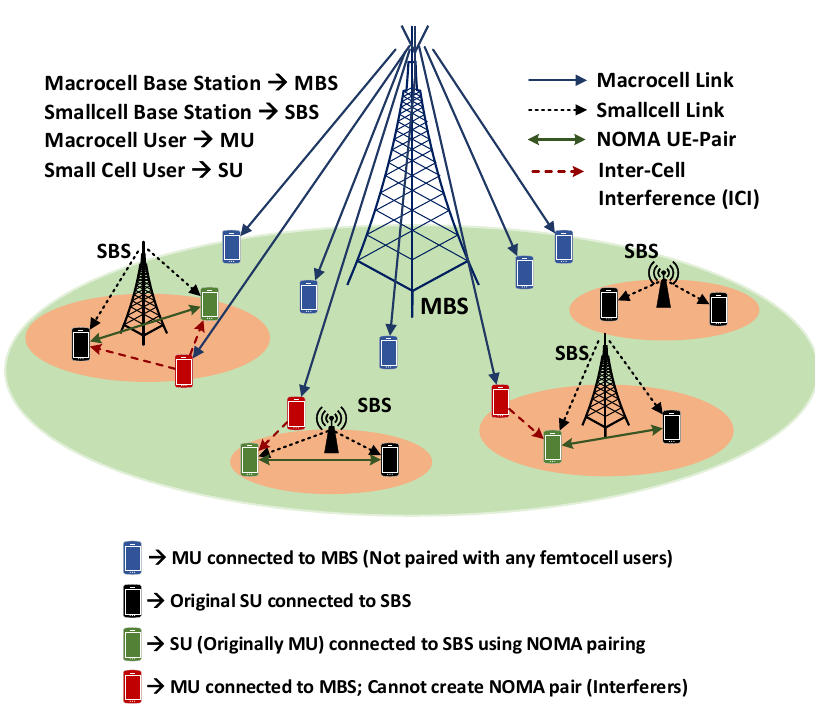
Figure 2. Small-cells deployed in a macrocell with non-orthogonal multiple access (NOMA).